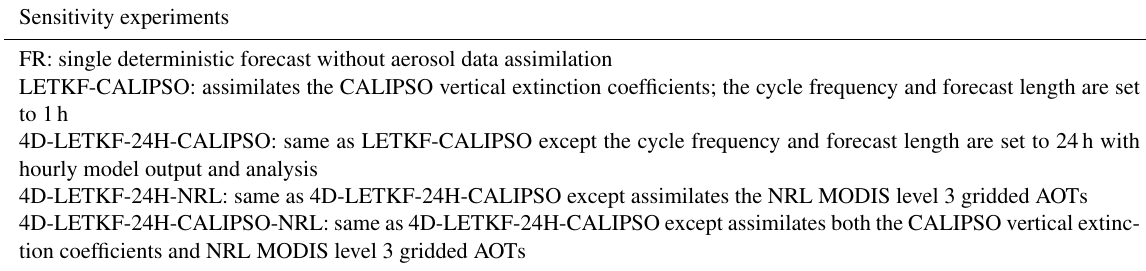
Table 1. Experimental design for the sensitivity tests in this study. Sensitivity experiments